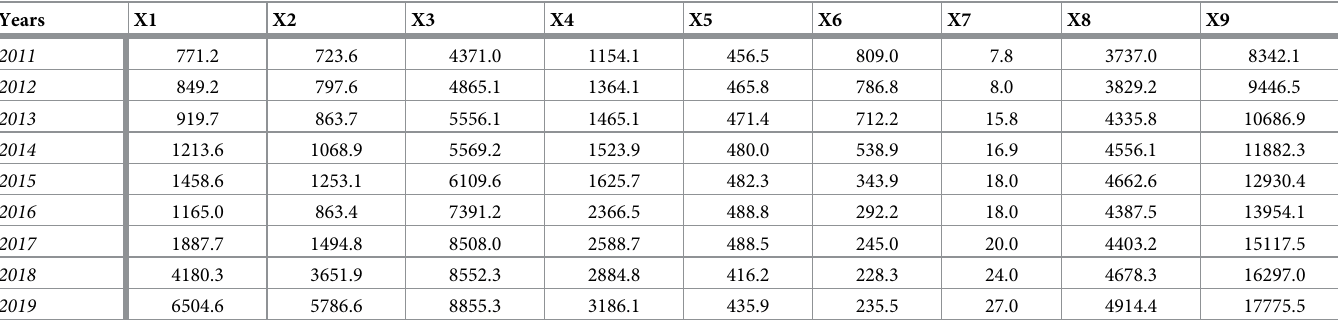
index in nine years; and Xj max represents the largest original data in nine years under each evaluation index. According to formula (1), the original data in Table 3 can be standardized, and the calcula- tion results are shown in Table 4. Table 3. Indicator data of Shandong Province from 2011 to